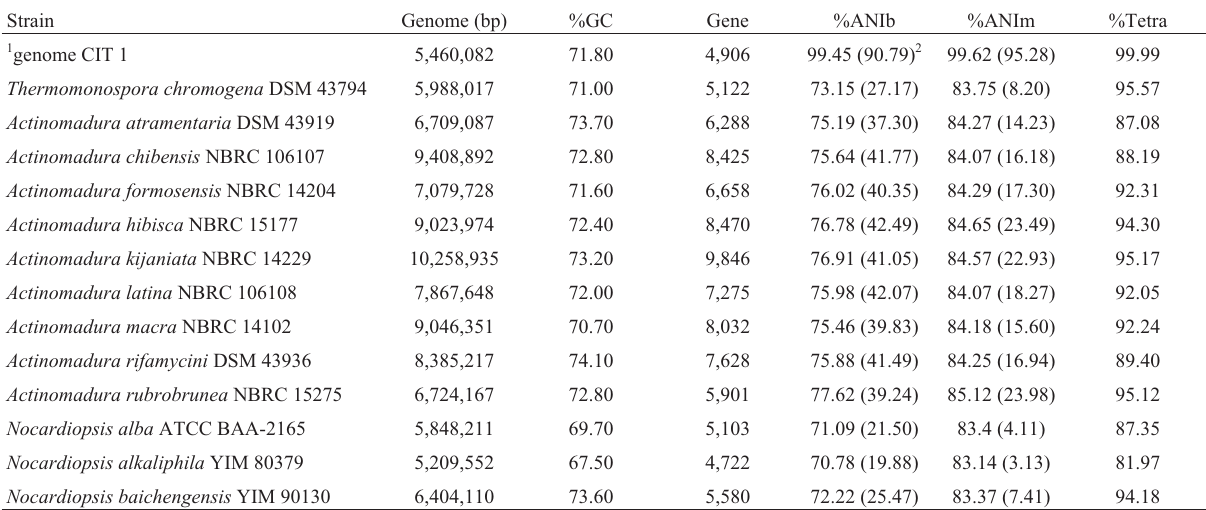
1 Partial genome retrieved from metagenomic DNA sequencing data from filter cake stored for 40 days. 2Percentage of total bases of the analyzed genome that aligned against the genome of T. curvata DSM 43183.